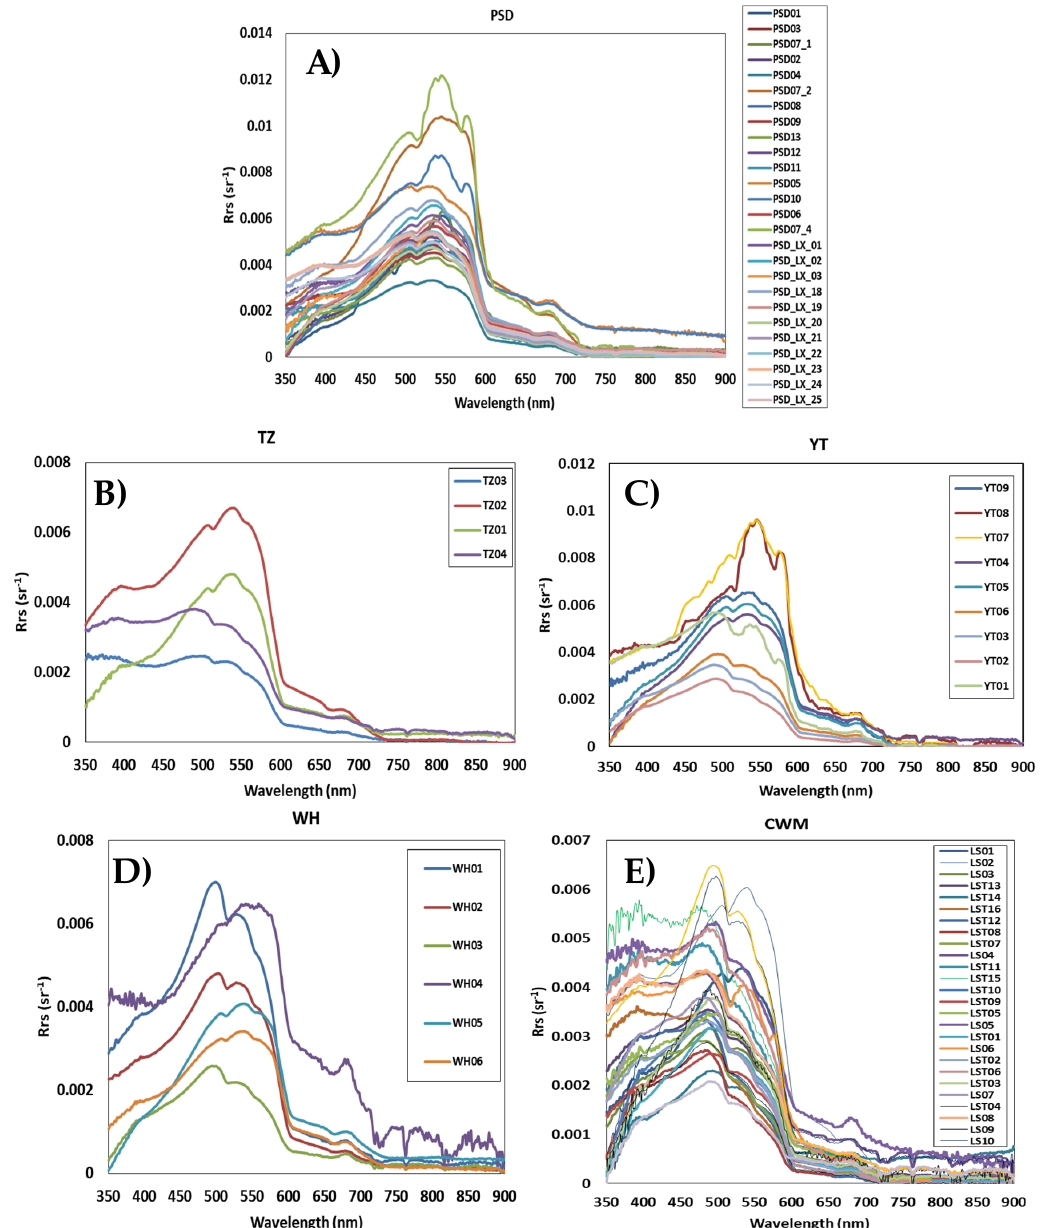
Figure A1. ( A – E ) In situ spectra of Rrs in five subregions over the YS.